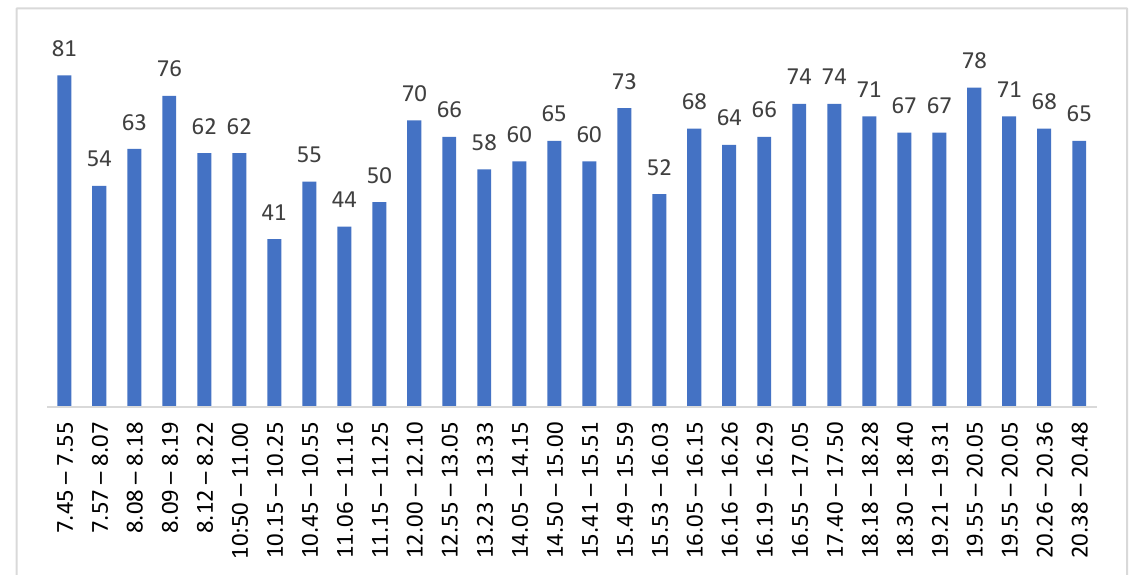
Figure 10. Time distribution on working days.